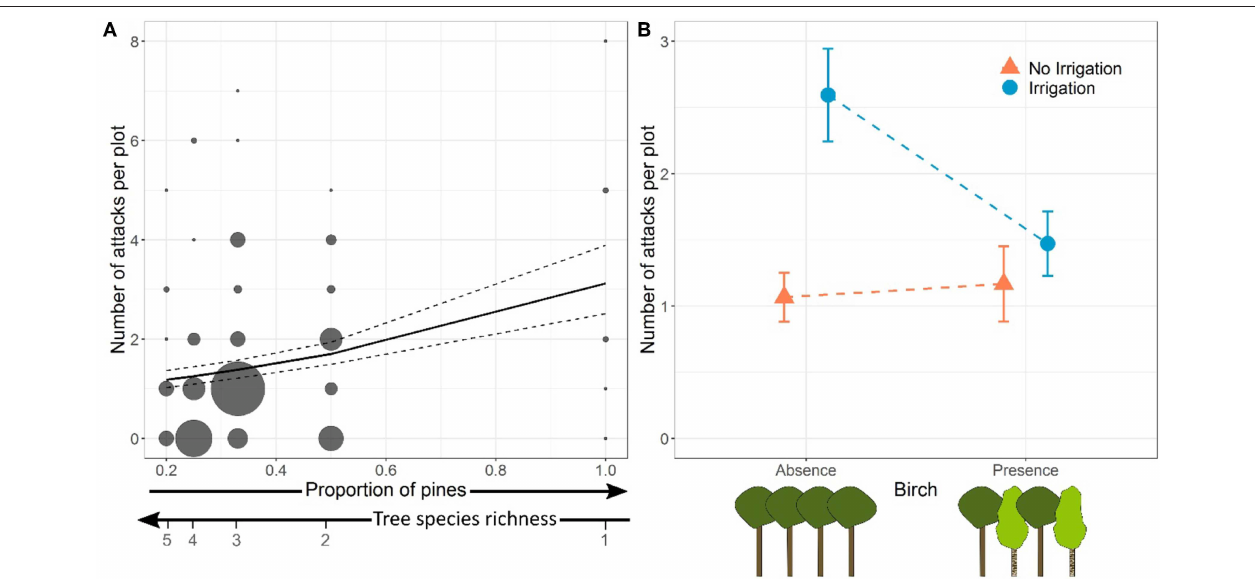
FIGURE 2 | Effects of proportion of pines (inversely proportional to tree species richness) (A) and of the presence of birch in irrigated and non-irrigated plots (B) on the total number of Dioryctria sylvestrella attacks per plot. In (A) , dot size is proportional to the number of plots. Model predictions and standard-errors are represented by the solid and dashed lines, respectively. In (B) , dots and bars represent means and standard-errors, respectively.